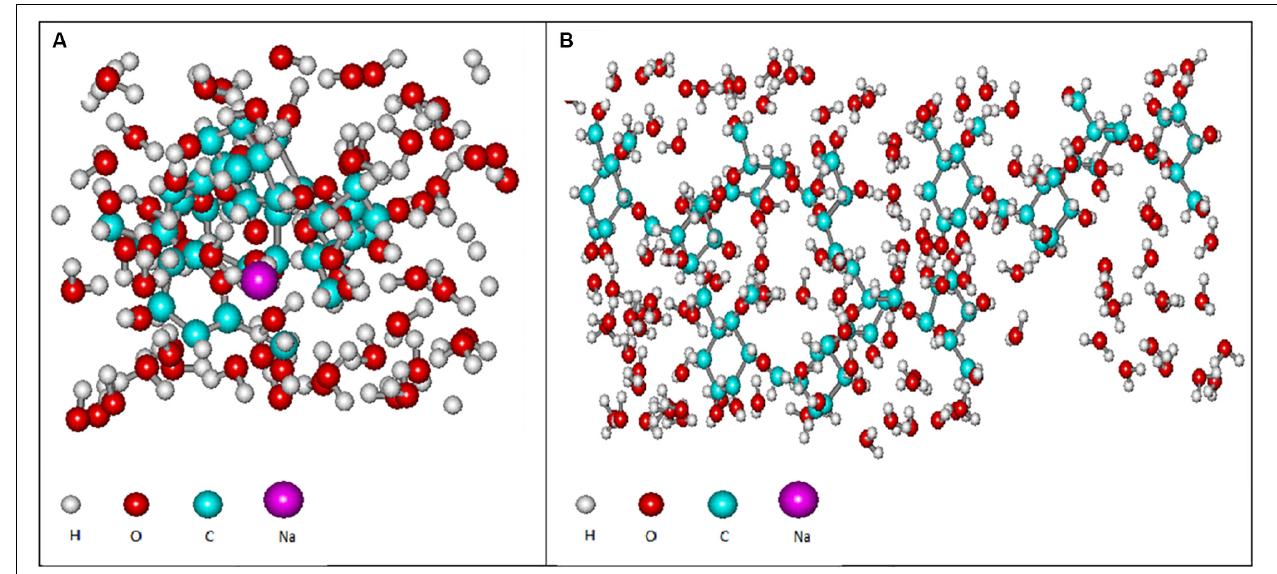
FIGURE 9 | Computer models of the hydrated polysaccharide of At. ferooxidans Ksh in the presence of salt (A) and without salt (B) , obtained by using semi-empirical and quantum mechanical